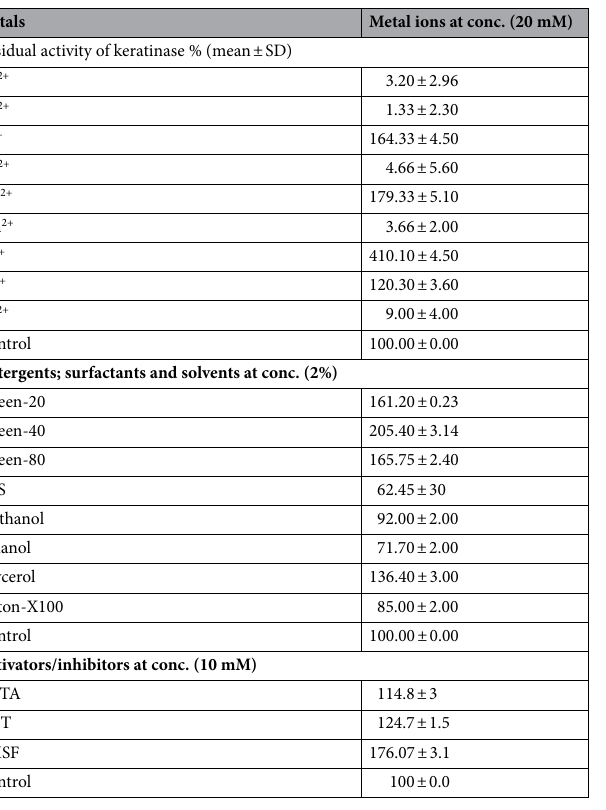
Table 6. Effect of the most promising concentration of metal ions, detergents, surfactants, activators, and inhibitors on the activity of the partially purified enzyme using the keratin-azure substrate and measured as